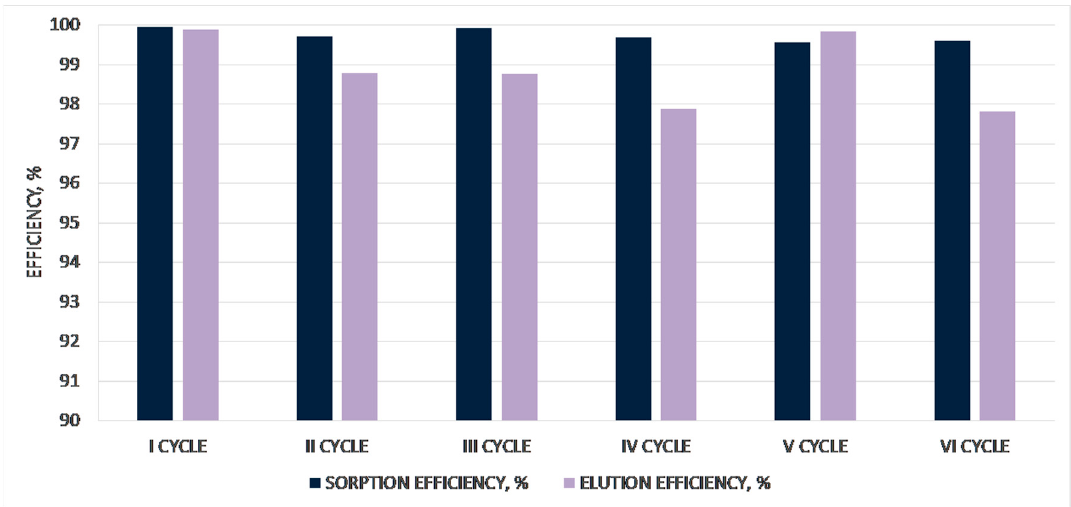
Figure 5. Sorption and elution efficiency of cobalt(II) ions in six subsequent cycles of ionite SGC650 work.